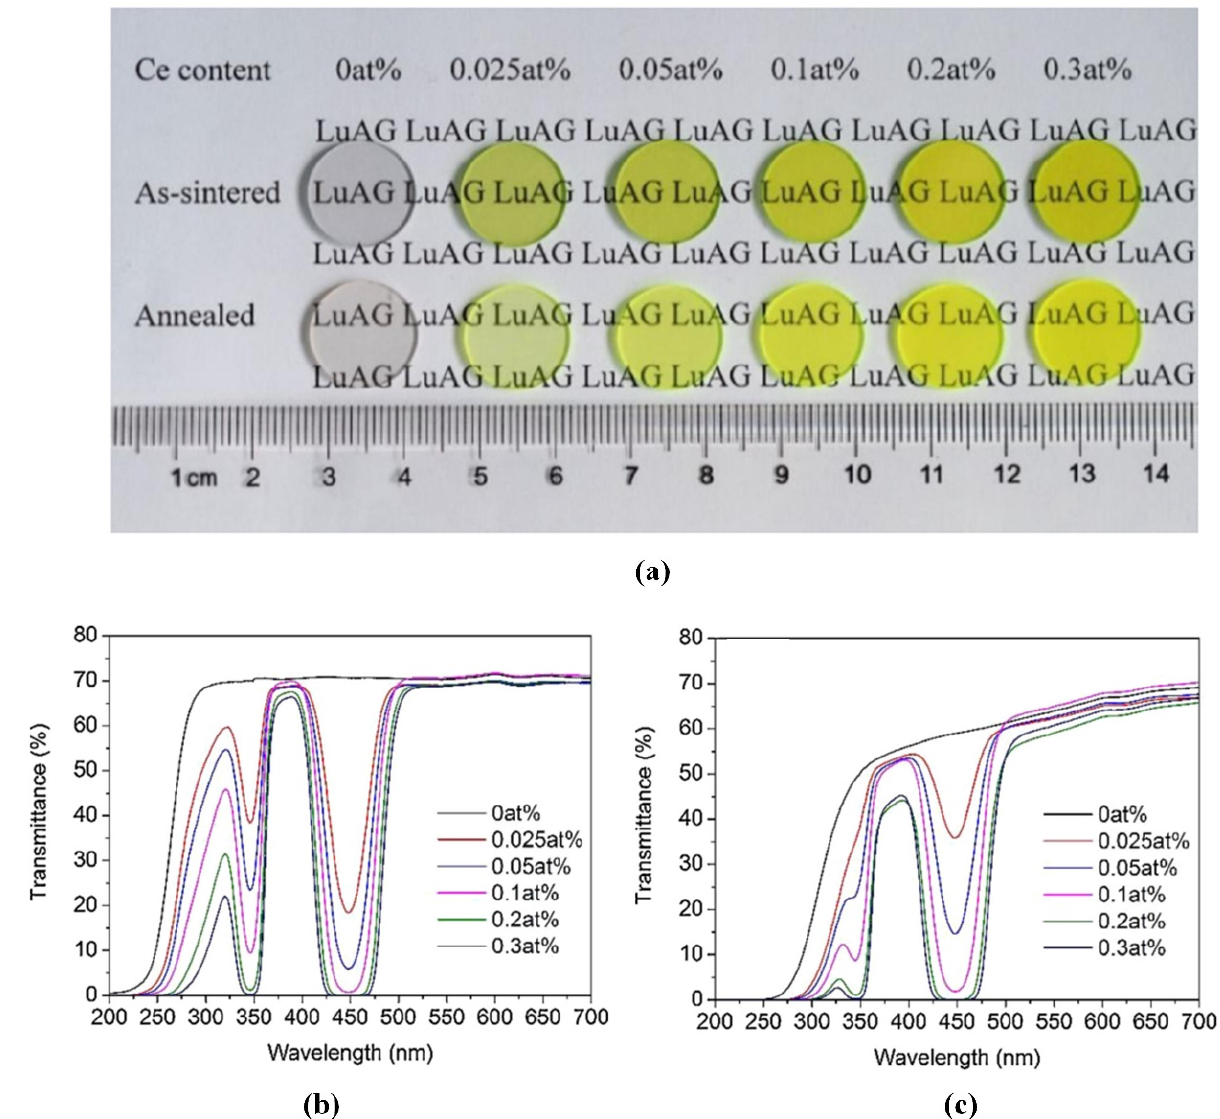
Figure 17. The properties of Mg:LuAG scintillation ceramics with different Ce contents (0.025~0.3 at.%) after sintering. ( a ) Transmittance of samples with different Ce contents; ( b ) Sintered state of different Ce content transmittances of Mg:LuAG ceramics; ( c ) Transmittance of annealed Mg:LuAG ceramics with different Ce contents [117]. Reprinted with permission from Ref. [117].